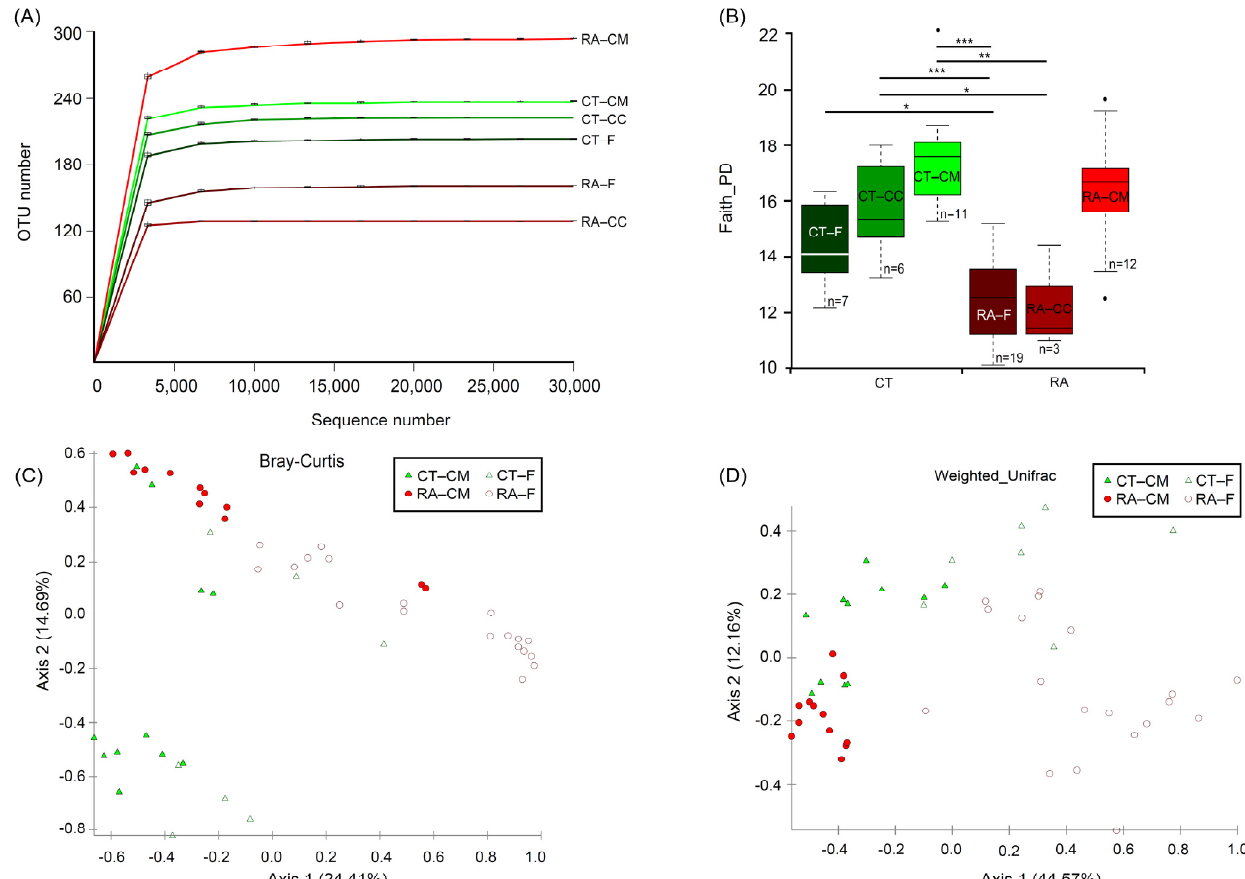
Figure 1. Alpha- and β -diversity analysis between RA and healthy ICR mice. ( A ) Rarefaction analysis of 16S rDNA data from RA mice and healthy controls. Each line represents fecal, cecal content and cecal mucus samples. Samples were rarified at an even depth of 31,794 sequences per sample for further analysis. Operational taxonomical units (OTUs) in this analysis were defined at 99% similarity. ( B ) Faith’s Phylogenetic Diversity comparisons were calculated by Kruskal–Wallis test. Data are median (horizontal line), interquartile range (box edges) and range (whiskers). * p < 0.05, ** p < 0.01, *** p < 0.001. ( C ) Principal coordinate analysis plot constructed by using the Bray–Curtis distance matrix. ( D ) Principal coordinate analysis plot constructed by using the weighted-UniFrac distance matrix. CT, healthy controls; RA, rheumatoid arthritis; CM, cecal mucus; CC, cecal content; F, fecal. All mice were from ICR background.